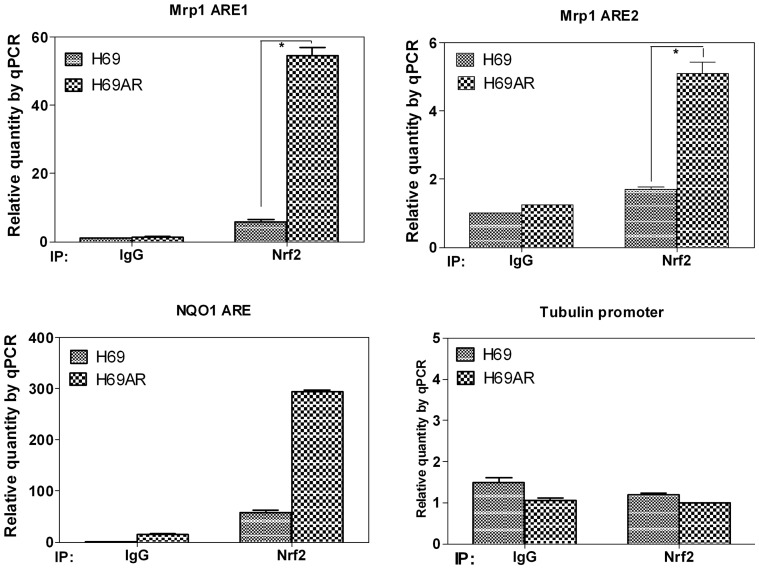
Nrf2-mediated induction of Mrp1 promoter activity depends both on ARE1 and ARE2 in small cell lung cancer cells.H69 and H69AR cells were cross-linked with formaldehyde. Sonicated chromatin was subjected to immunoprecipitation with antibodies against Nrf2 or normal IgG. Precipitated DNA was followed by realtime PCR analysis with primers against Mrp1 ARE1 (panel A), Mrp1 ARE2 (panel B), NQO1 ARE (panel C) and Tubulin promoter (panel D). Experiments were performed three times and a representative of three experiments was shown here.